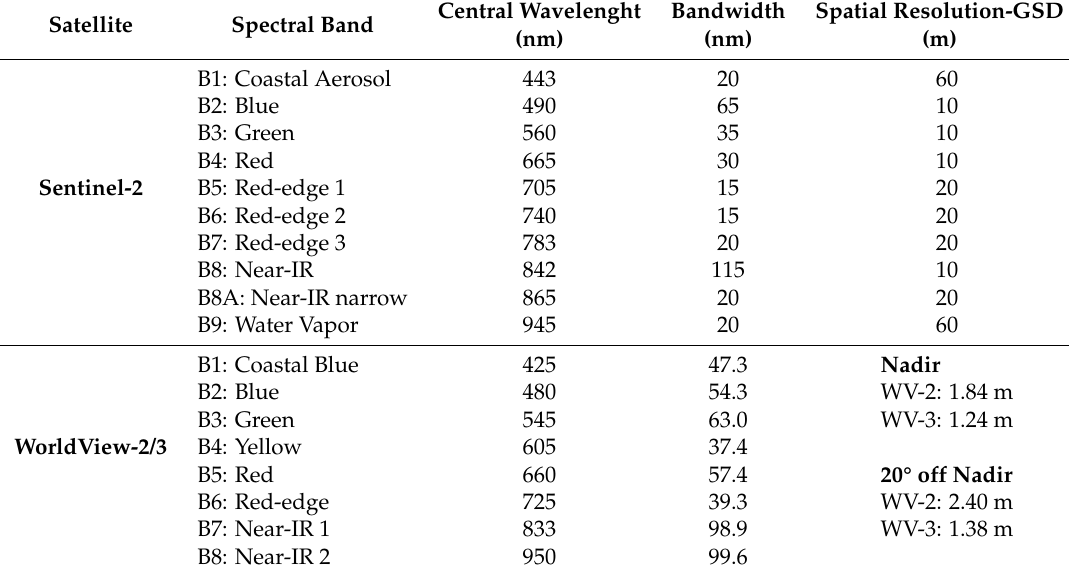
Table 1. Spatial and spectral characteristics of Sentinel-2 and WorldView-2/3 satellites (visible and near infrared multispectral